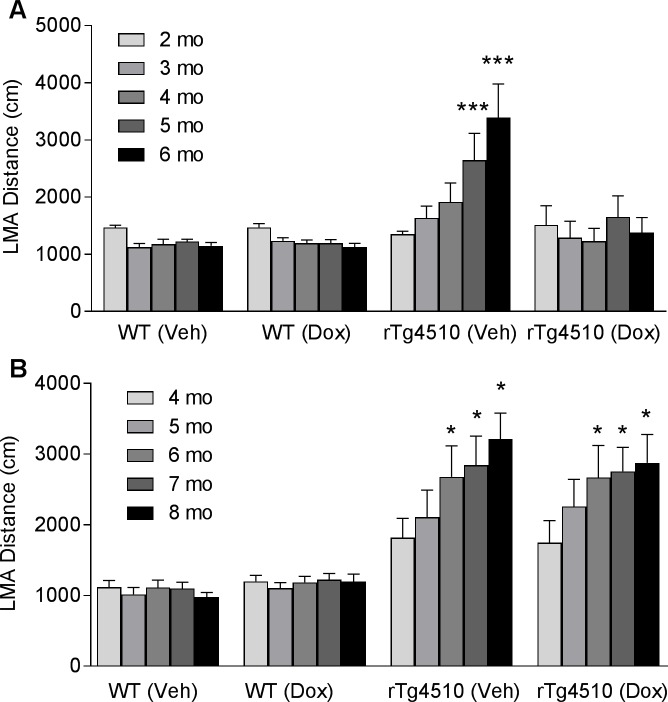
Effects of doxycycline treatment on progression of hyperactivity in rTg4510 mice are age-dependent.WT and rTg4510 mice were dosed with either normal mouse chow (Veh) or normal mouse chow containing doxycycline at 1g/kg (Dox) for 4 months starting at either 2 months of age (A) or 4 months of age (B). LMA was tested monthly after the onset of treatment to monitor the progression of hyperactivity. (n = 8 WT and 22–24 rTg4510 mice per group; ***p<0.001, Two-way ANOVA followed by Bonferroni's test compared to baseline groups).